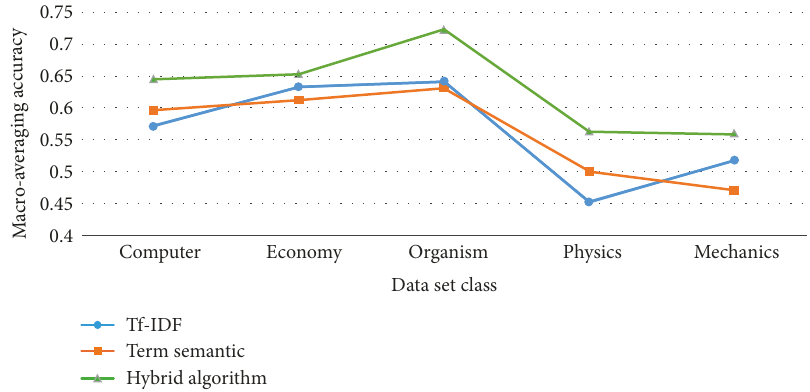
Figure 12: Macroaverage recall ratio analysis of three methods in DKM algorithm.